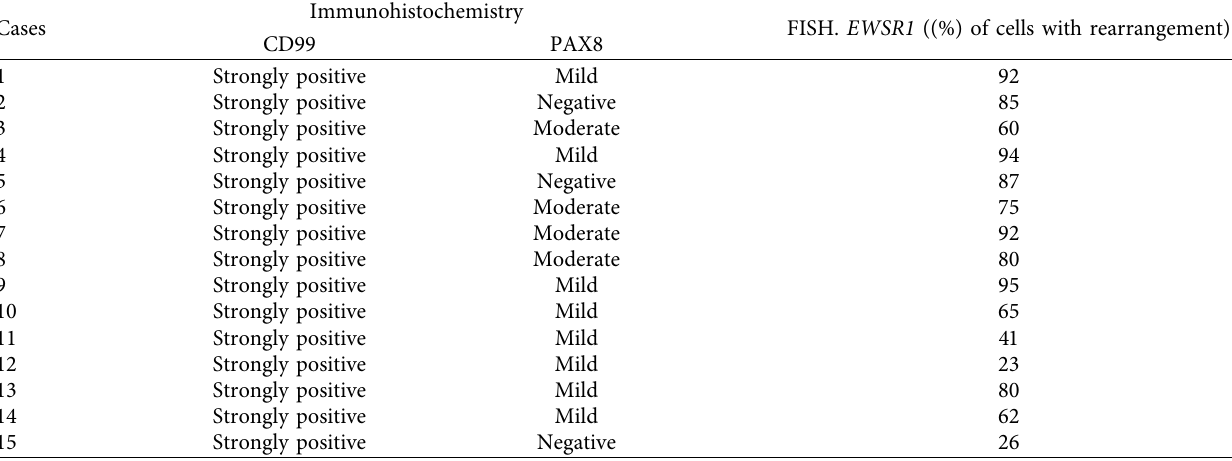
Table 4: Immunohistochemistry and FISH